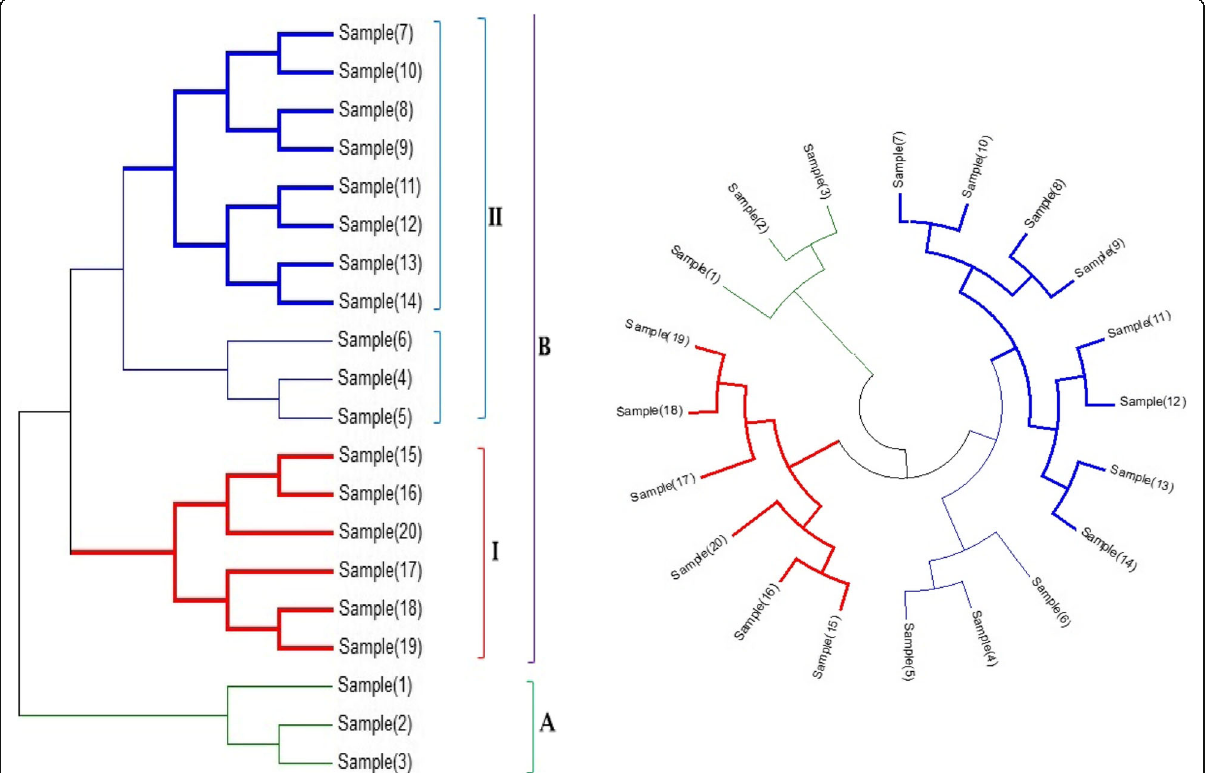
Fig. 4 Molecular phylogenetic analysis of different Triticum species by bootstrapping analysis depending on amino acid sequence of maturase- like protein. The phylogenetic analysis was performed in MEGA program version 6 by maximum likelihood method depending on the JTT matrix- based model (Jones, et al. 1992). The bootstrap consensus tree deduced from 1000 replicates is obtained to represent the evolutionary history of the species analyzed. Branches corresponding to partitions reproduced in less than 50% bootstrap replicates are excluded (Felsenstein,